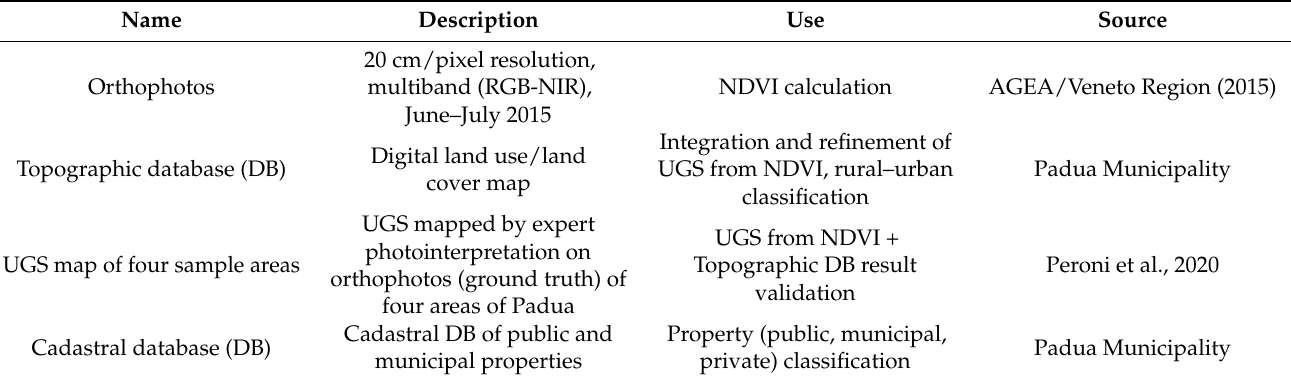
Table 1. Main input spatial data used and their